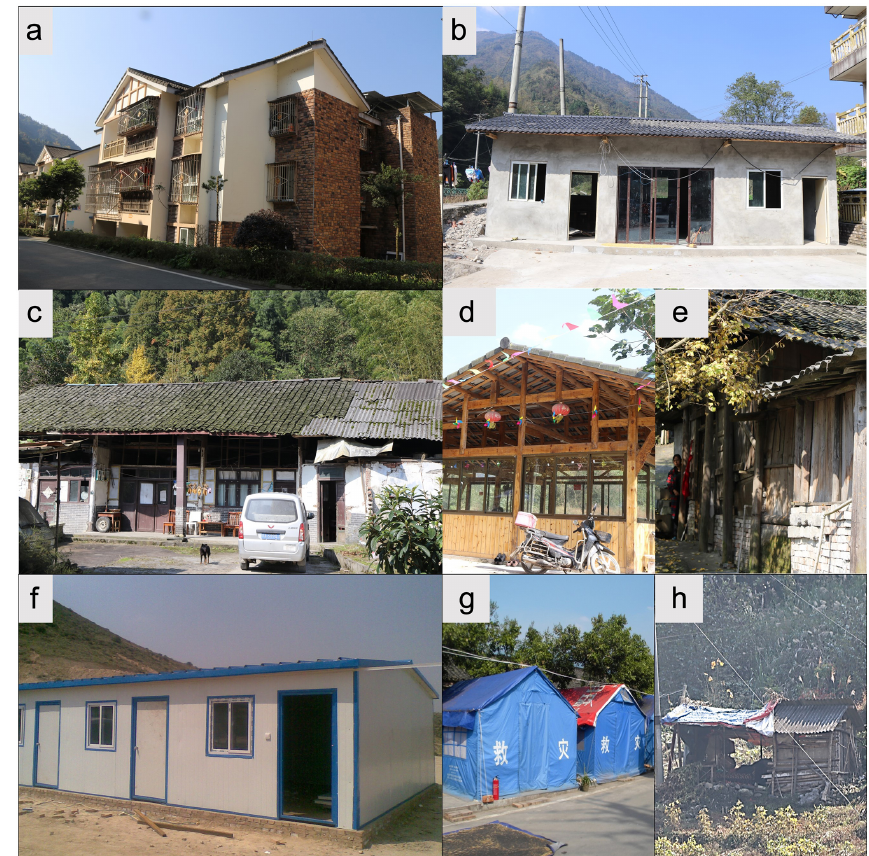
Figure 2. Examples of building construction types in the study area. (a) Reinforced-concrete frame (RCF) residences built by the reconstruc- tion teams from Shanghai. (b) Reinforced-concrete masonry (RCM) building of a hotel. (c) Wood and brick residence (WB). (d) Wooden structure (W) serving as restaurant. (e) Wooden residence with walls made by wooden plates and bricks. (f) Prefabricated metal (PFM) temporary houses. (g) Tents distributed by the government. (h) A shack made from wood, asbestos tiles and waterproof